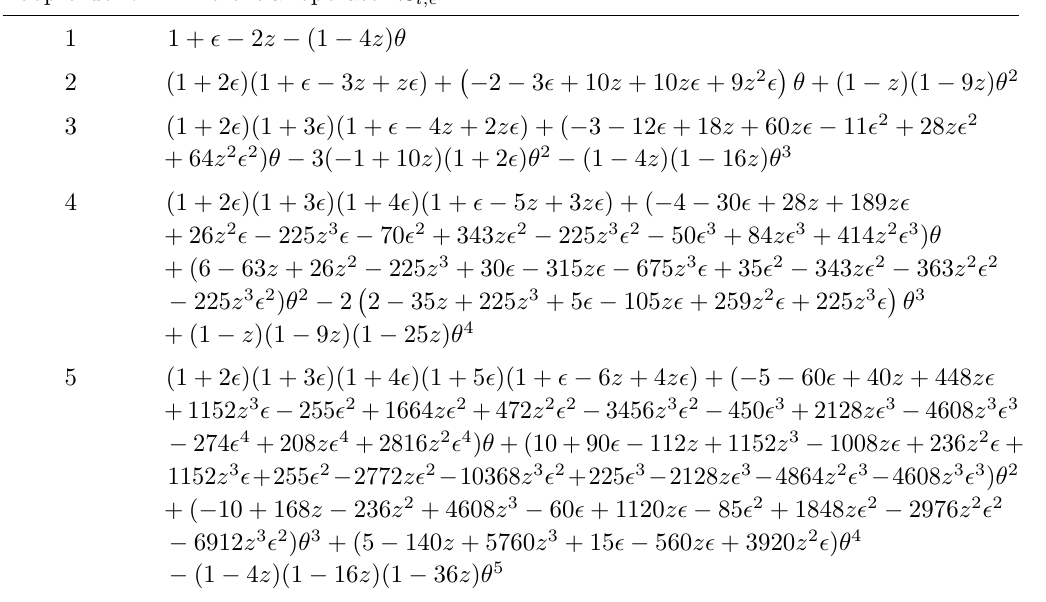
Table 2 . The homogeneous differential operators L l,(cid:15) that annihilate the maximal cuts of the banana integrals in D = 2 − 2 (cid:15)